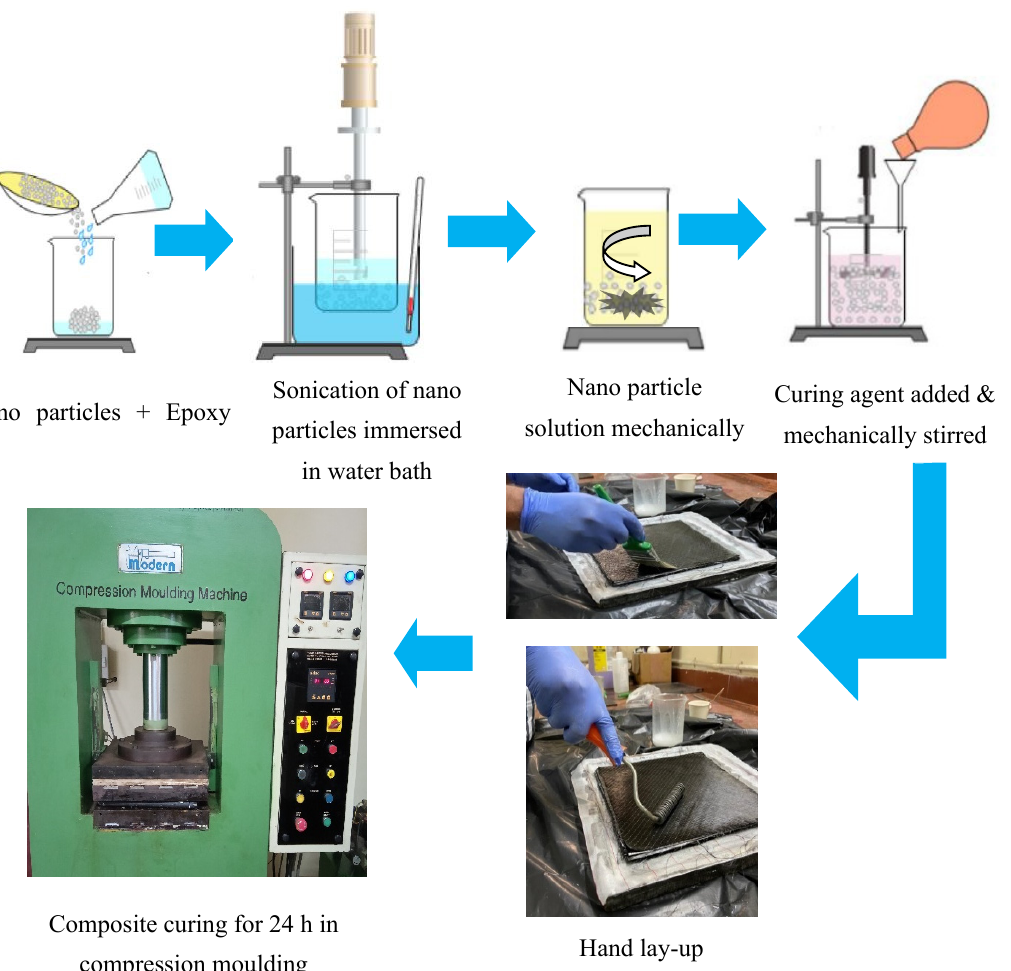
Figure 1. Schematic representation of fabricating the hybrid nanocomposites.